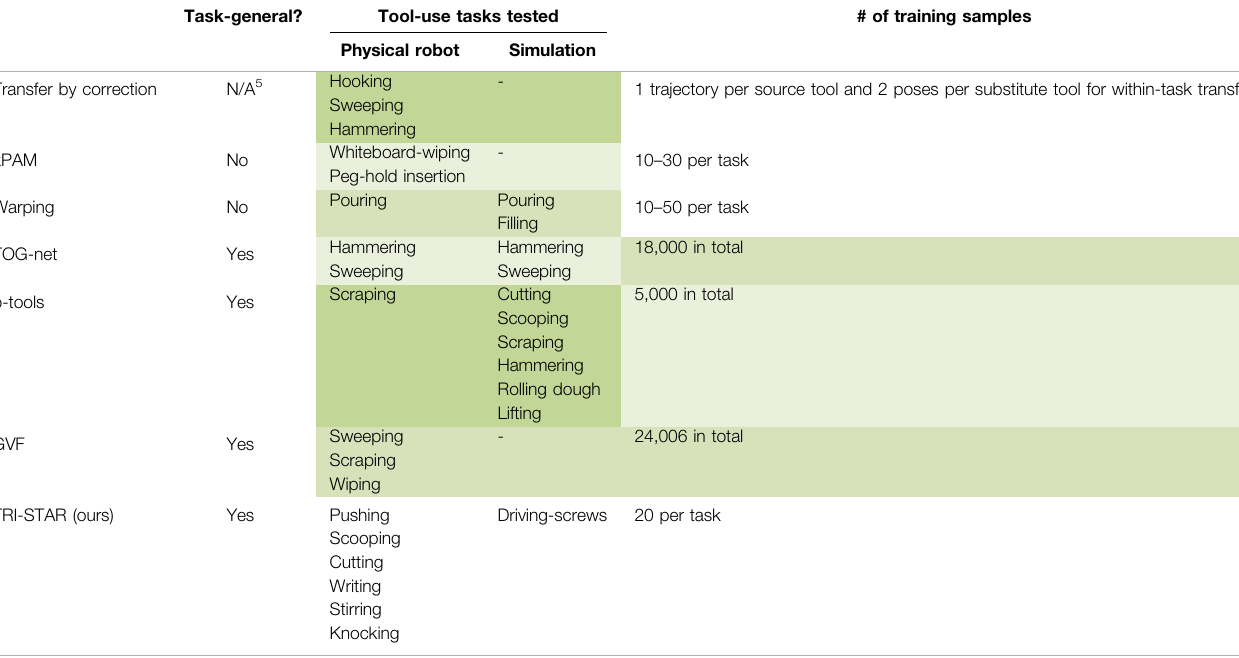
TABLE 1 | Comparing different tool-use frameworks: transfer by correction (Fitzgerald et al., 2019), kPAM and kPAM 2.0 (Manuelli et al., 2019; Gao and Tedrake, 2021), warping (Brandi et al., 2014), TOG-net (Fang et al., 2020), p-tools (Abelha and Guerin, 2017; Gajewski et al., 2019), GVF (Xie et al., 2019), and TRI-STAR (ours). The different frameworks are listed by row, ordered by relevancy to our work. Cell shading indicates how desirable a demonstrated feature of the corresponding framework is, with darker shading indicating higher desirability. Comparison of Task-Generality and Data Ef fi ciency. The tables show that not all frameworks are task-general (e.g., do not require pre-speci fi ed knowledge for each individual task). Moreover, TRI-STAR was demonstrated with a wider range of tasks than other frameworks. Additionally, TRI- STAR requires fewer training samples per task than other task-general